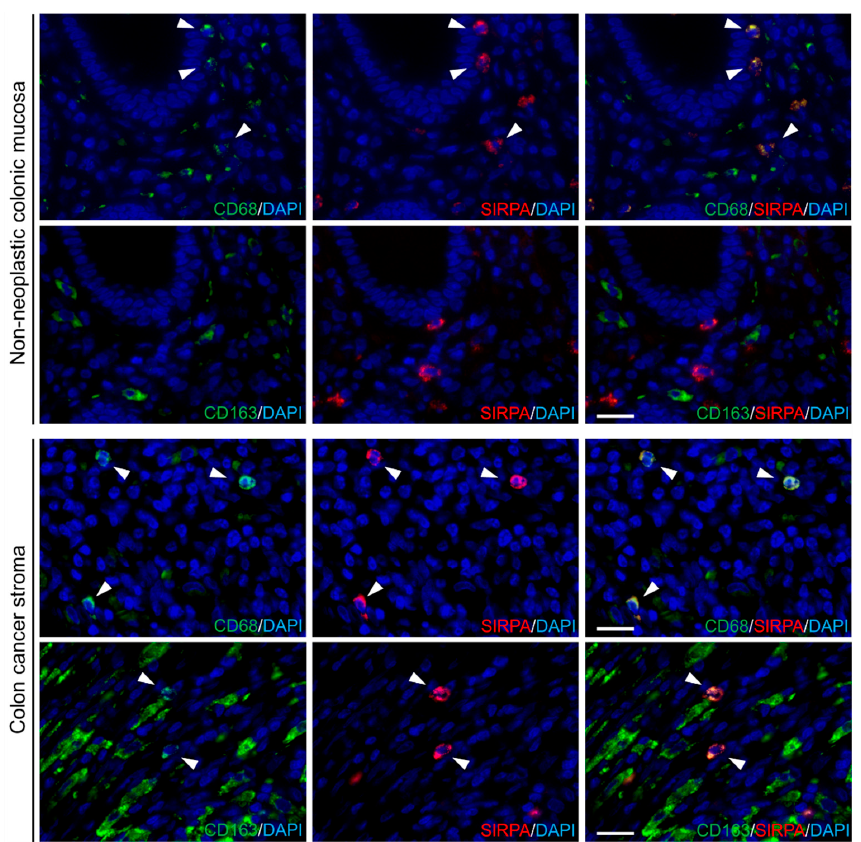
Figure 2. SIRPA was expressed in the subpopulation of CD68- and CD163-positive cells. SIRPA was expressed in the subset of CD68-positive cells in non-neoplastic colonic mucosae (upper panels). In colon cancer stroma, SIRPA expression was observed in both CD68- and CD163-positive tumor-associated immune cells (TAIs) (lower panels). Bar, 20 μ m. The clinical, pathological, and immunohistochemical features of the analyzed tumors are summarized in Tables 1 and 2 according to CD47 and SIRPA expression, respectively. Table 1. Characteristics of colorectal carcinomas with or without CD47 expression. a, p -values were calculated by the Chi- square test for CD47 expression. b, t -test or c, Cochran–Armitage trend test was used to calculate p -values. The Bonferroni- corrected p -value for significance was p ≈ 0.0042 (0.05/12).